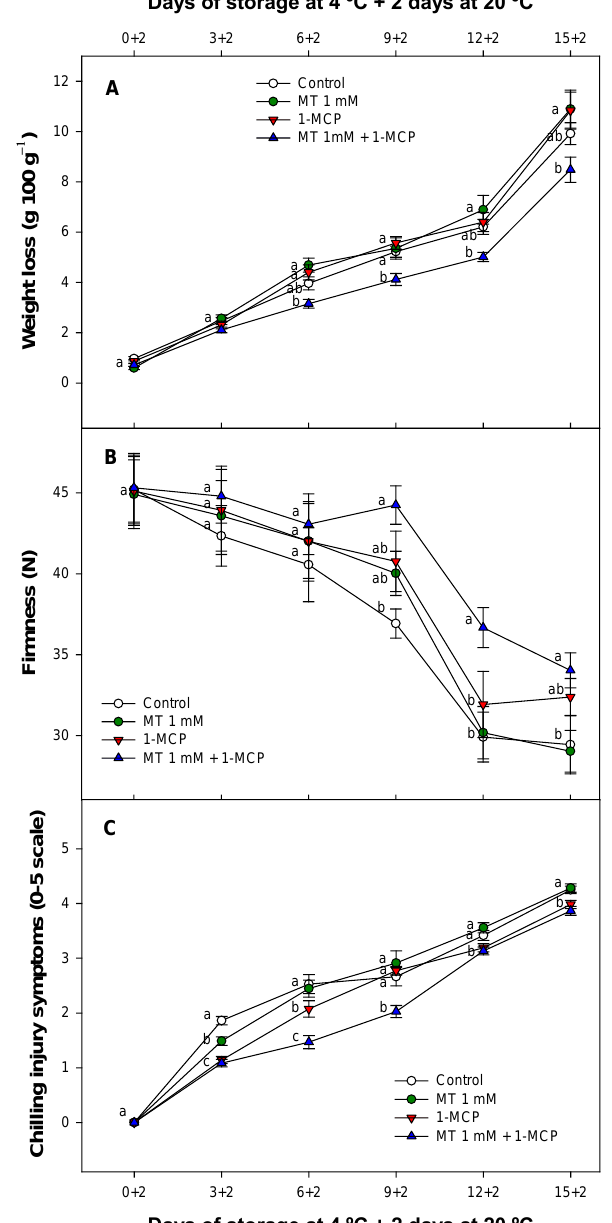
Figure 1. Evolution of weight losses (g 100 g −1 ) ( A ) fruit flesh firmness (N) ( B ) and chilling injury (0 – 5 scale) ( C ) of ‘Cronos’ zucchini fruit treated with melatonin at 1 mM (MT) or distilled water (Control) with or without 1-MCP during cold storage plus 2 days at 20 °C. Data are the mean ± SE (n = 3). Different lowercase letters show significant differences ( p < 0.05) among treatments for each sampling date.